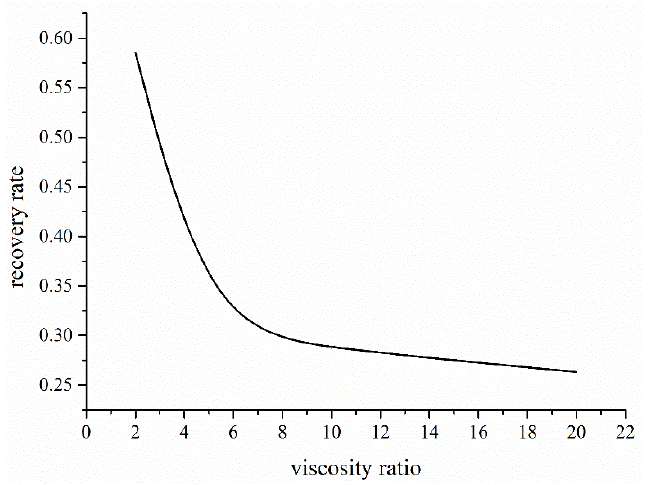
Figure 14. Variation of the final oil recovery rate with the oil–water viscosity ratios.